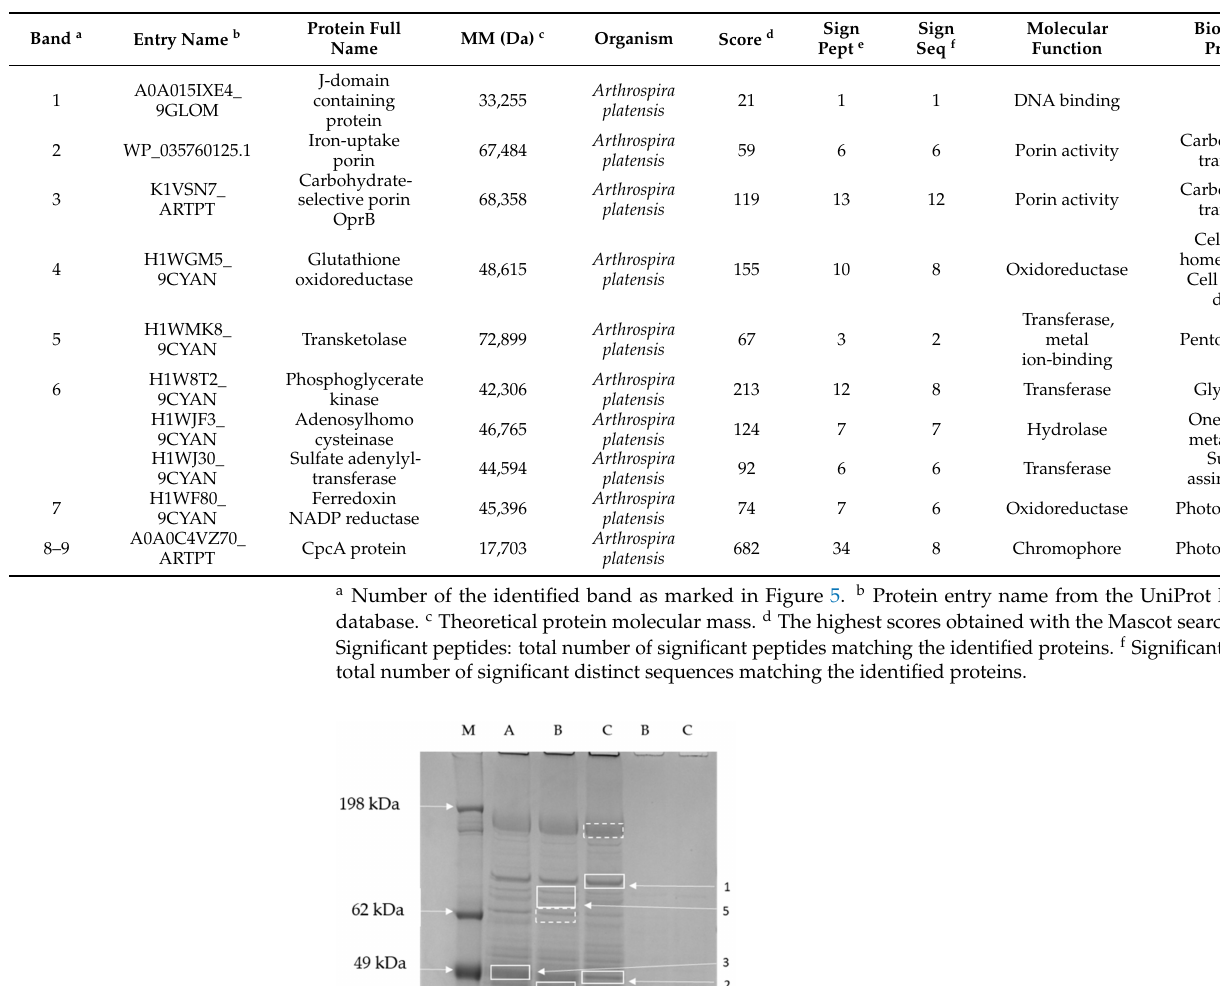
Table 2. Protein identification in fractions from cytosolic extracts of A. platensis using mass spectrom- etry.